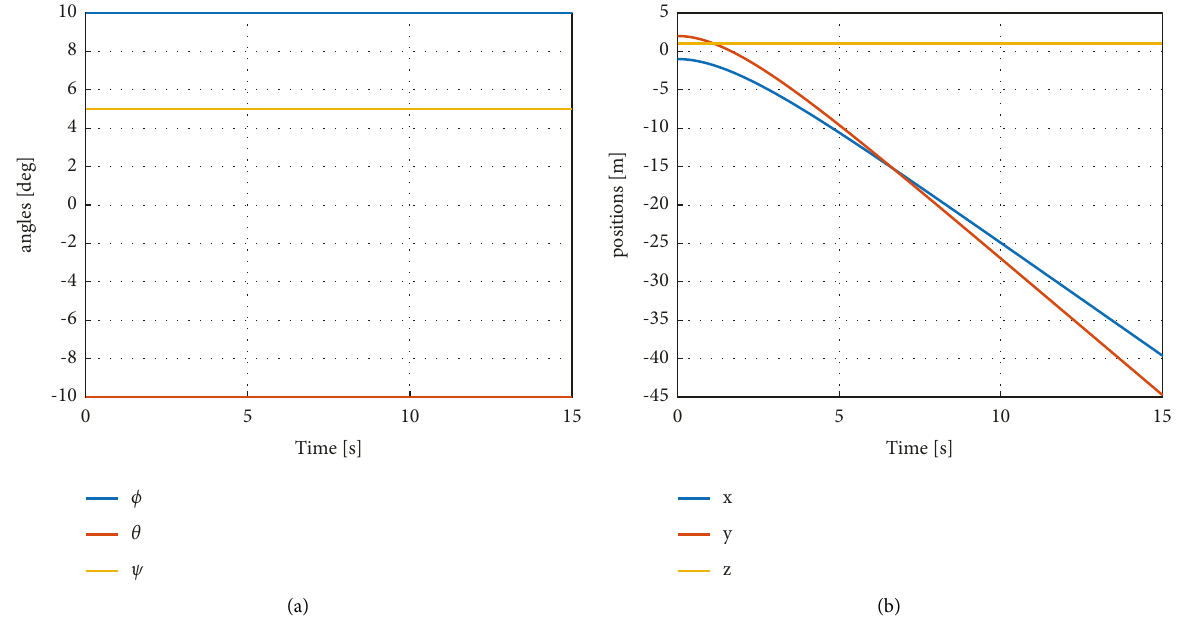
Figure 5: Control inputs for the positions x , y , and z and the angles ϕ , θ , and ψ . Table 3: Gain values for PD controller.